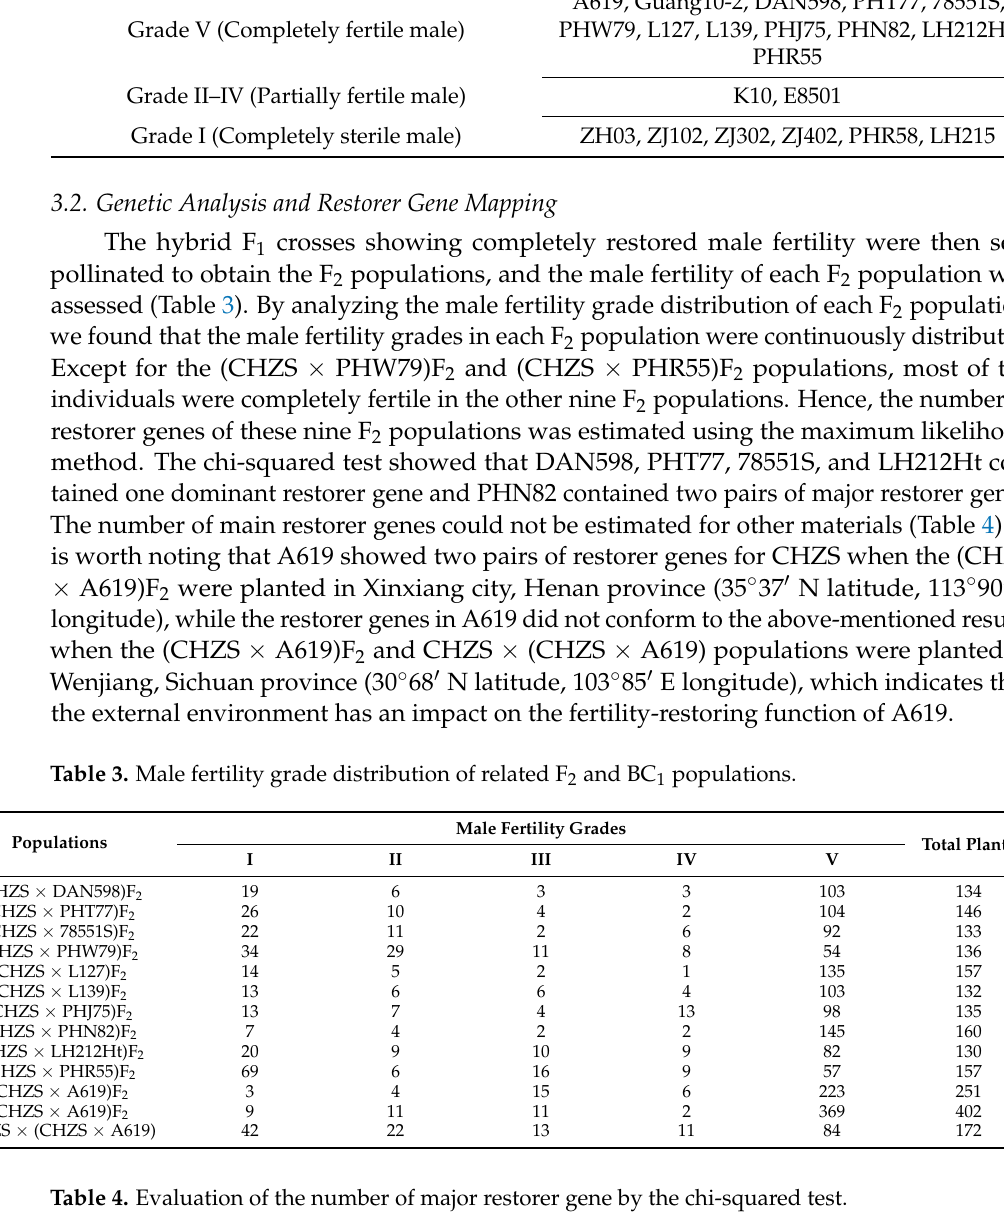
Table 2. Fertility ratings of F 1 progenies derived from the cross between CHZS and the tester lines. Male Fertility of F 1